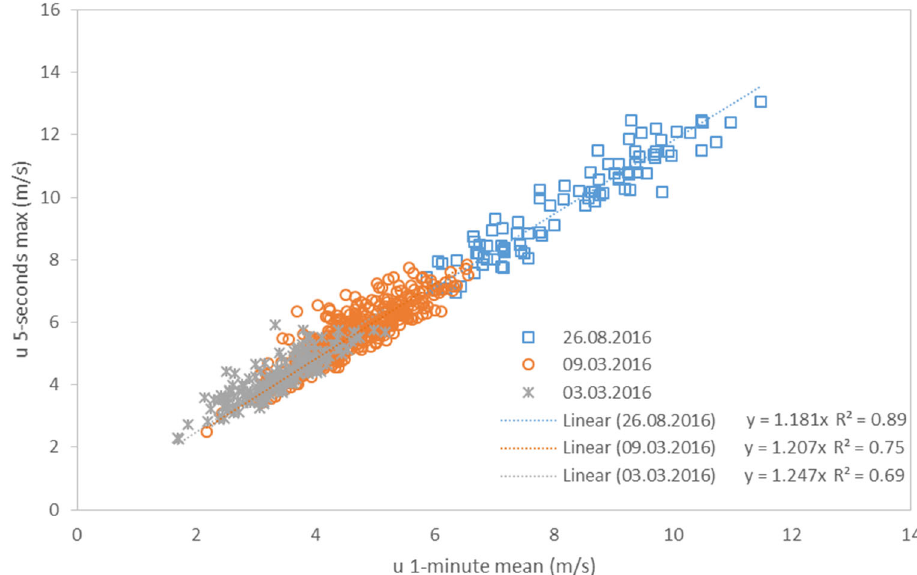
Figure 4. Comparison of the maximum wind velocity of a 5 s interval measured within a one ‐ minute mean .